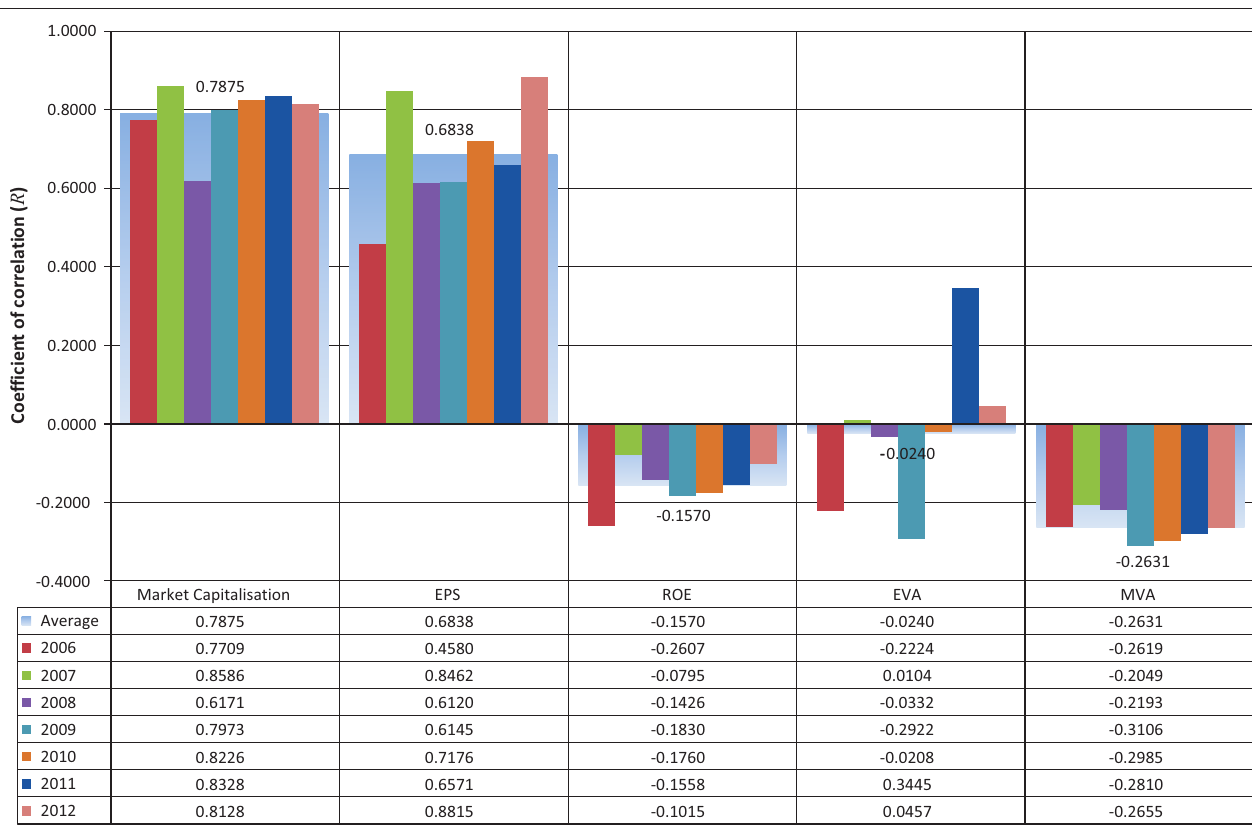
FIGURE 6: Fixed pay – short term incentive mix (2006–2012).